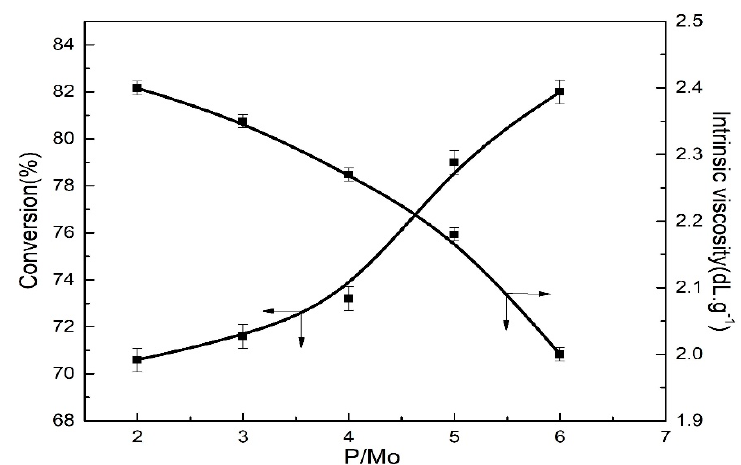
Figure 3. Effect of P:Mo mole ratios from 2 to 6 on the polymerization activity and intrinsic viscosity at a Bd:Ip mole ratio of 9:1. Polymerization conditions: [M] = 0.18 g · mL − 1 , Mo:[M] = 4 × 10 − 4 , Al:Mo = 10, T = 60 °C, nBd:nIp = 9:1, t = 7 h.